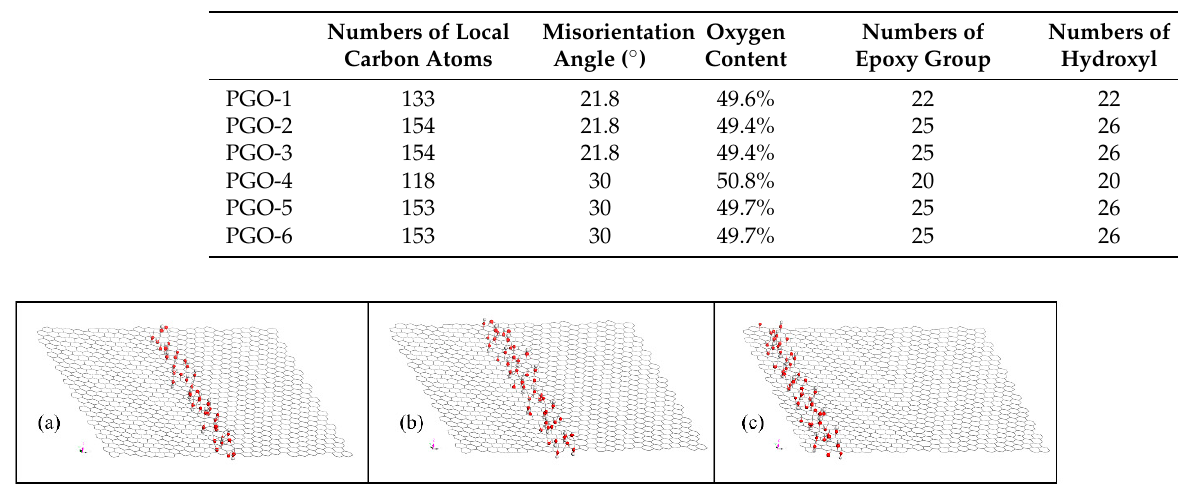
Table 2. Main parameters of three PGO models with different functional group distributions.